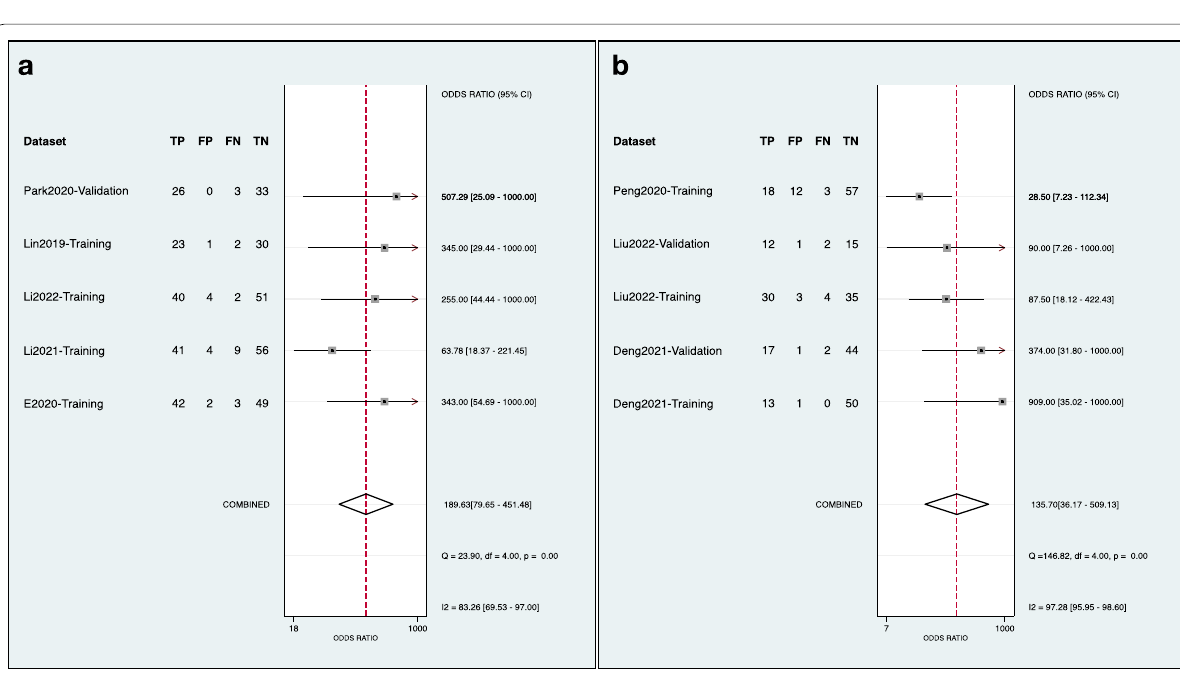
Fig. 5 Forest plots of diagnostic odds ratio for differentiation diagnosis. a Autoimmune pancreatitis versus pancreatic cancer by CT; b mass-forming focal pancreatitis versus pancreatic cancer by